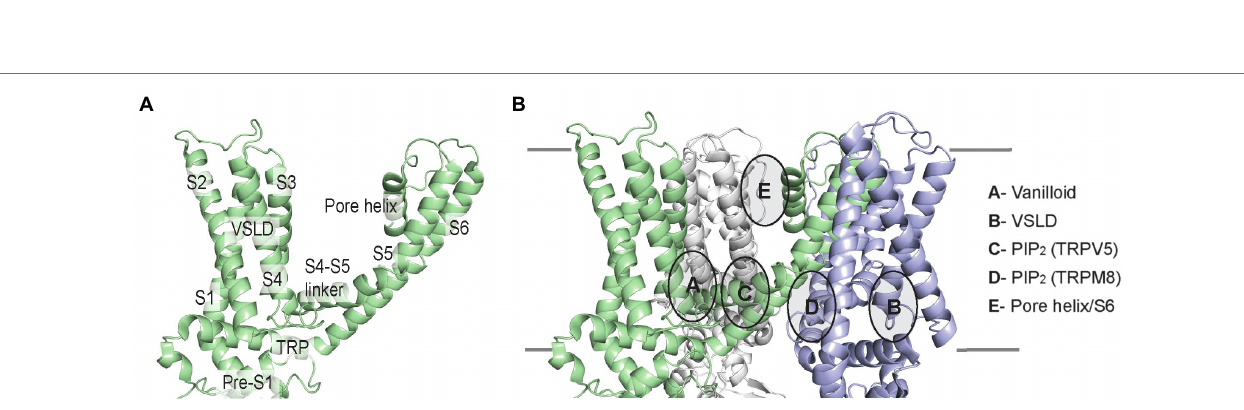
FIGURE 6 | TRP channel TMD architecture, and schematic of lipid-drug or lipid binding sites in TRP channels illustrated using the TRPV1 lipid nanodisc structure (pdb 5irz). (A) Single subunit of TRPV1 labeling the helices and domains. The VSLD consists of S1-S4 helices. (B) Three subunits of the TRPV1 tetramer are shown indicating the location of lipid-drug or lipid binding sites as described.